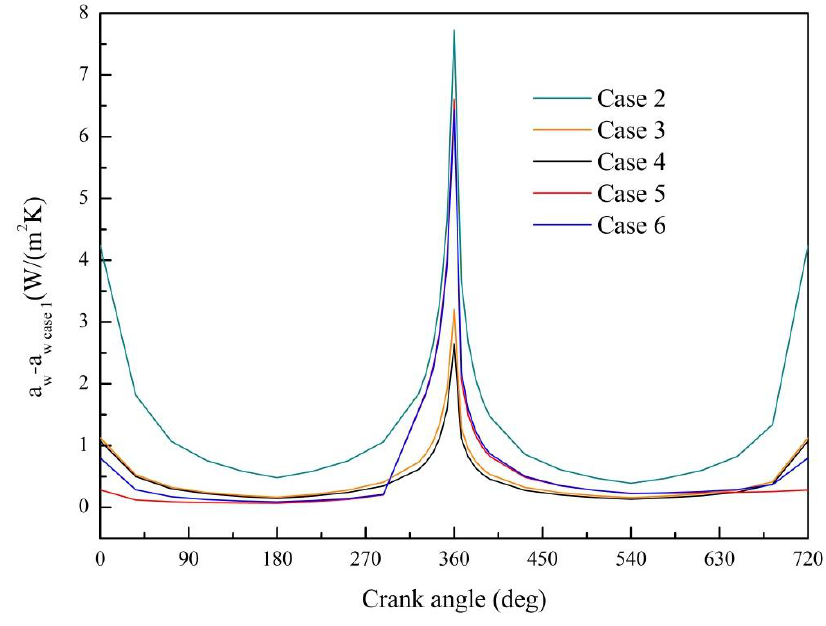
Figure 7. Difference of heat transfer coefficient under different coolant conditions.